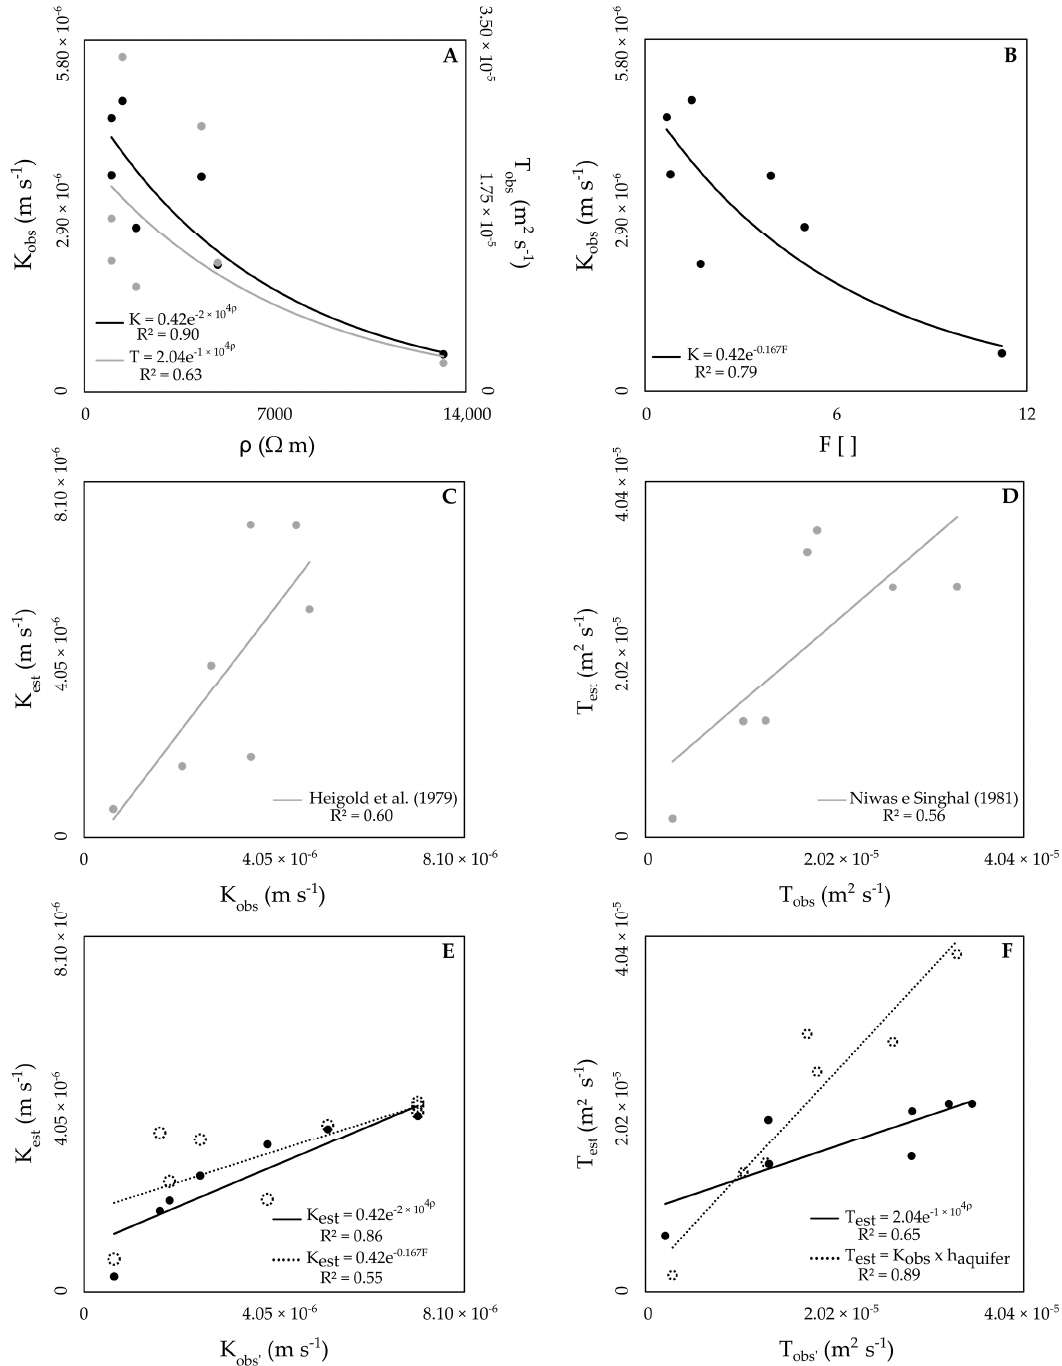
Figure 4. Relationship between geoelectric and hydraulic parameters in a porous aquifer. ( A ) Hydraulic conductivity (K obs ) and transmissivity (T obs ) values, obtained by slug test, as a function of the electrical resistivity values of the aquifer ( ρ aquifer ). ( B ) K obs as a function of the aquifer formation factor (F). ( C ) Comparison between the estimated hydraulic conductivity values (K est ), according to Heigold et al. (1979) [24], and K obs . ( D ) Comparison between the estimated transmissivity values (T est ), according to Niwas e Singhal (1981) [8], and T obs . ( E ) Comparison between the estimated hydraulic conductivity values (K obs’ ), according to Heigold et al. (1979) [24], and K est with equations presented in Figure 4A,B. ( F ) Comparison between the estimated transmissivity values (T obs’ ), according to Niwas e Singhal (1981) [8], and T est by equation in Figure 4A and K obs × h aquifer